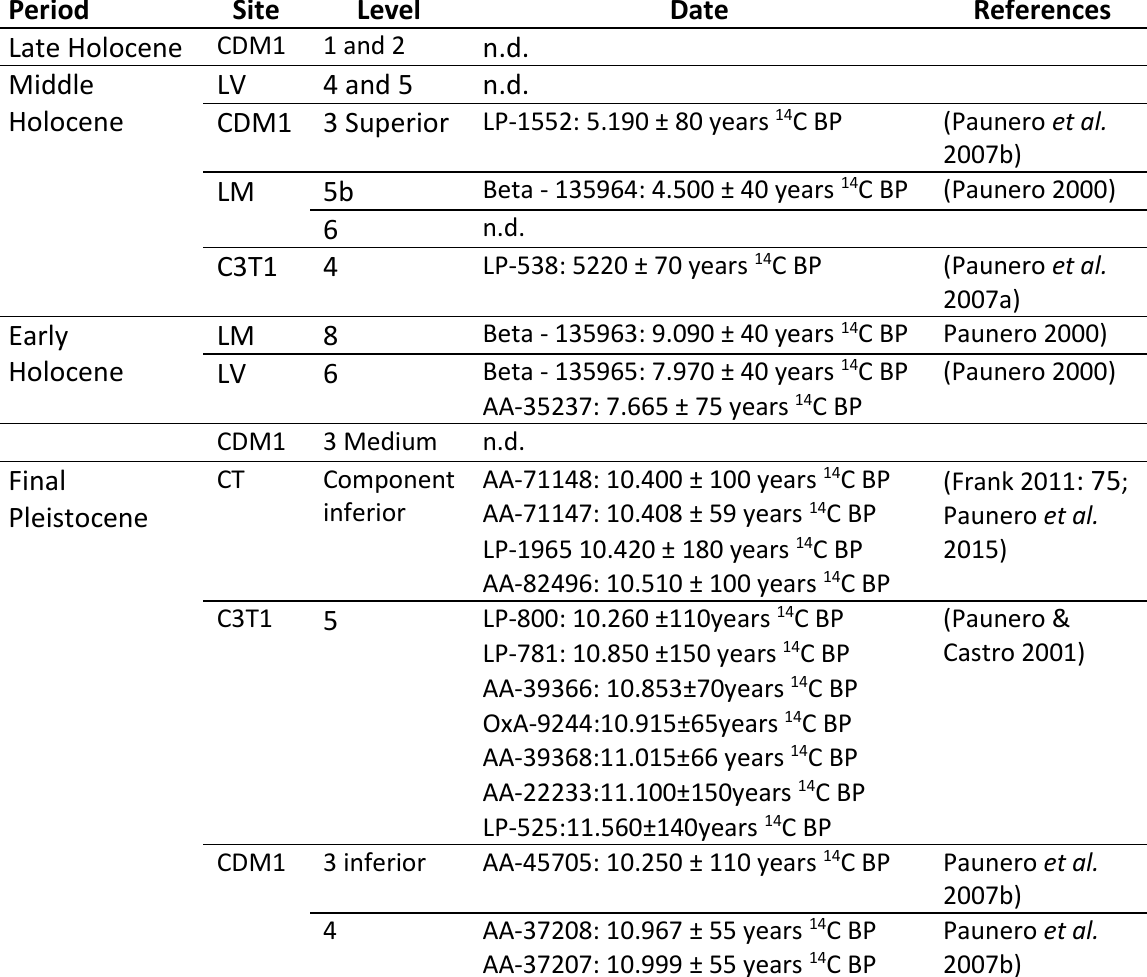
Table 1.14C dates of analyzed components. Abbreviations: n.d. - not